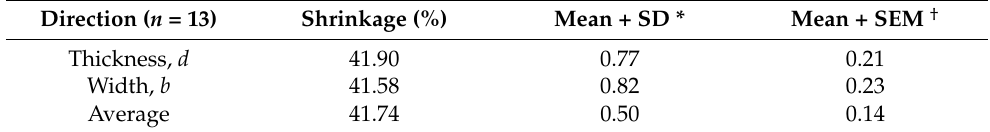
Table 3. Shrinkages of the